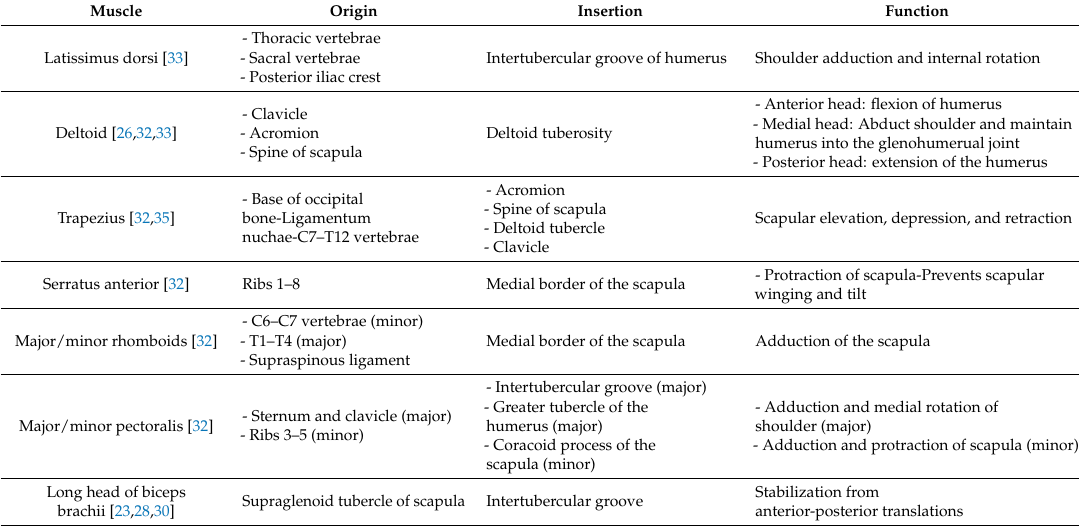
Table 1. Summary of other significant shoulder